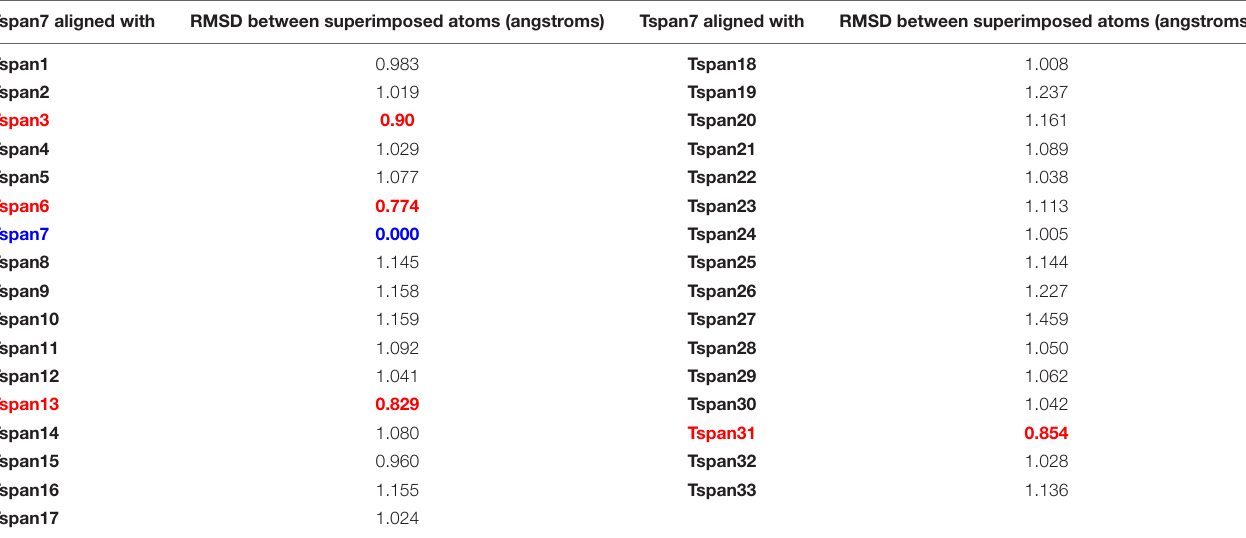
TABLE 2 | RMSD values (in Å) for human Tspan1-Tspan33 in alignment with Tspan7. Tspan7 aligned with RMSD between superimposed atoms (angstroms) Tspan7 aligned with RMSD between superimposed atoms (angstroms) Tspan1 0.983 Tspan18 1.008 Tspan2 1.019 Tspan19 1.237